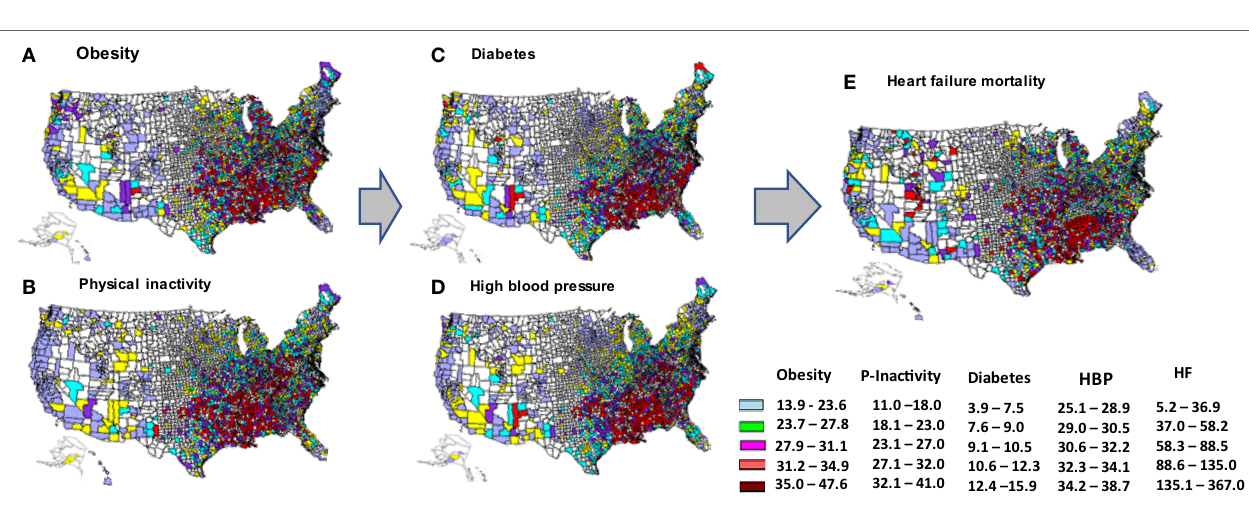
FigUre 3 | County-level variations in age-adjusted prevalence of obesity (a) , physical inactivity (B) , diabetes (c) , high blood pressure (HBP) (D) , and age-adjusted mortality from heart failure (e) , depicted by quintiles of each variable. The arrows represents hypothesized pathway. (Note: the states of Alaska and Hawaii are shown on the left bottom in each map for the purpose of being presented in a figure. Please refer to a U.S. map for their exact